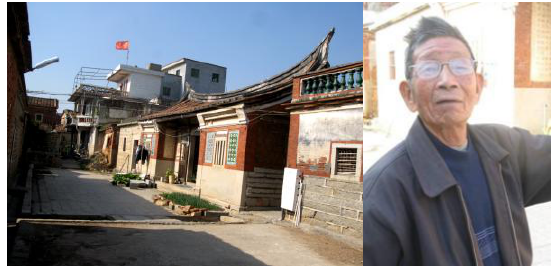
Figure 5. Historic residence and Owner, Chang Lao